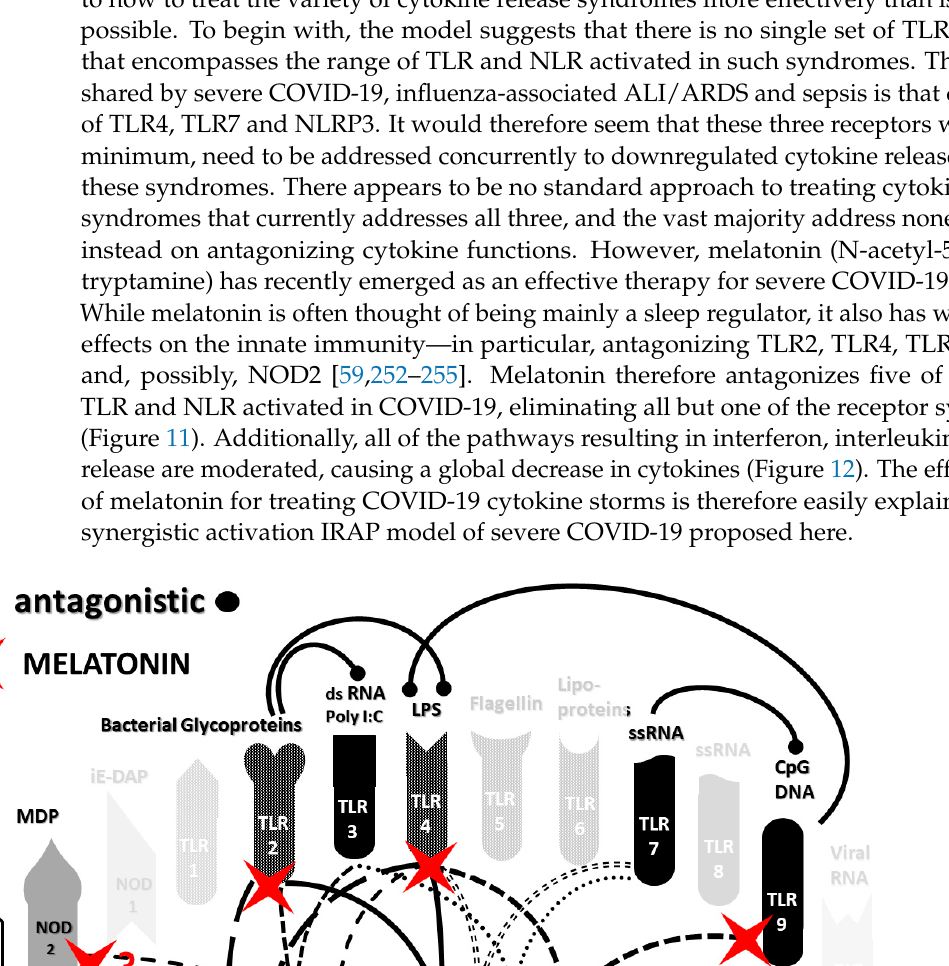
Figure 12. Figure 1 adapted to illustrate the effects of Anakinra, an IL-1 receptor blocker (purple stars), and Tocilizumab and Sarilumab, IL-6 receptor blockers (blue star) that only antagonize one or two cytokines compared with the effects of melatonin (red stars), which downregulates NOD2, TLR2, TLR4, TLR9 and NLRP3, resulting in decreases in the produc- tion of all major cytokines (circled in red). The model of innate immunity regulation proposed here may also be useful for eval- uating the likelihood that other therapies will be useful in treating severe COVID-19 and, particularly, the cytokine storm accompanying it. Consider, as examples, Anakinra, a hu- man IL-1 receptor antagonist, and Tocilizumab and Sarilumab, monoclonal antibodies that block the IL-6 receptor and, thus, its signal transduction pathway [256,257]. Each one neutralizes only one type of cytokine among the dozen that are released during a cytokine storm (Figure 12). Thus, one would expect each one to have a minimal effect on COVID- 19 symptoms and progression, which is, in fact, the case. While a meta-study of Tocili- zumab found a weak but statistically significant reduction in mortality among ventilated patients [258], the largest double-blinded, randomized study for treating COVID-19 pa- tients found no benefits compared to the standard care [259]. A head-to-head comparison